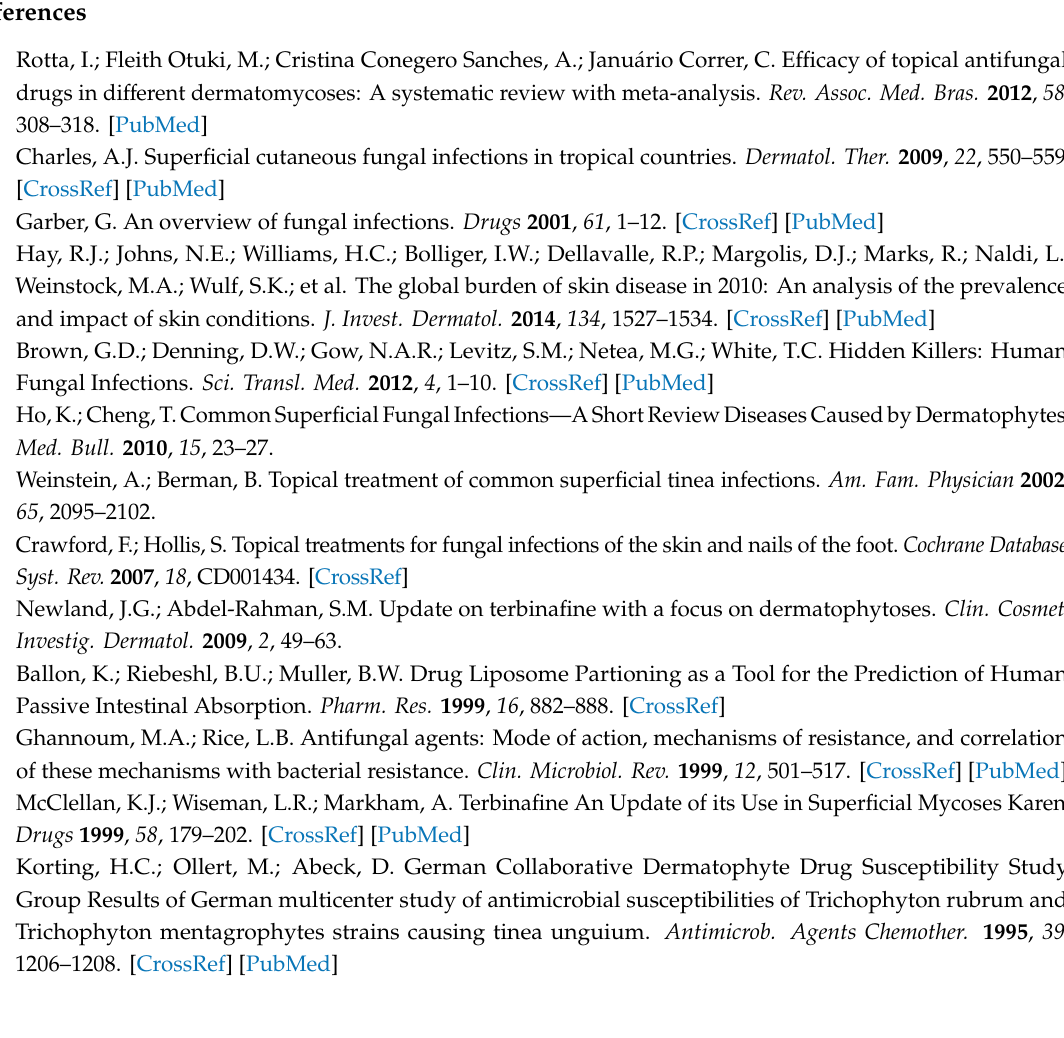
Figure S1: 13 C NMR spectrum of TBF-free base, Figure S2: 13 C NMR spectrum of TBF salt, Figure S3: TGA ( a ) and DSC ( b ) analysis of TBF salt, Figure S4: Recovery (%) of TBF-free base in a series of solvent systems after 24, 48, 72, 96, and 120 h at 32 ± 1 ◦ C ( n = 3; mean ±